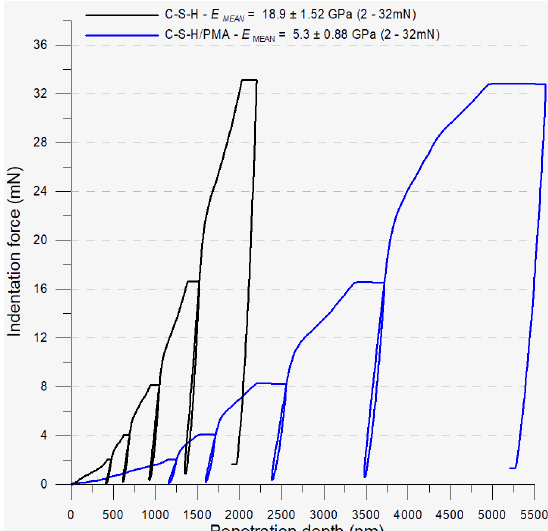
Figure 7. Load-penetration curves (2-32 mN) obtained by nanoindentation on samples C-S-H and C-S-H/PMA.